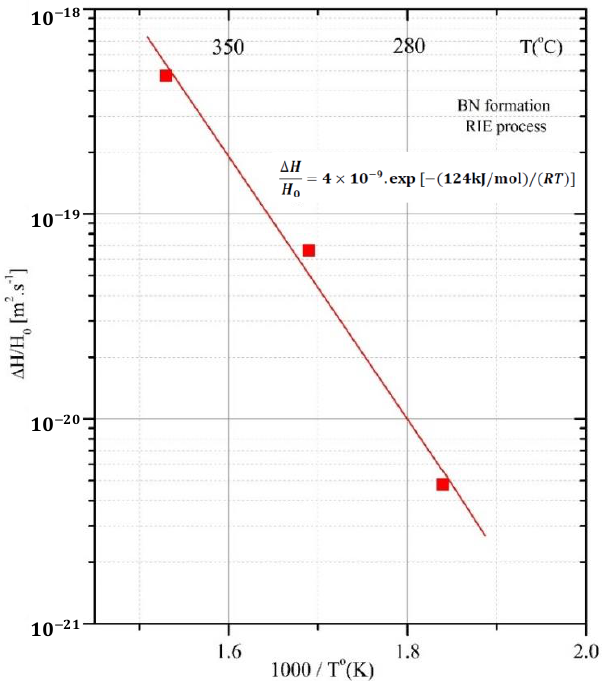
Figure 14. Arrhenius plot of BN phase-formation process via RIE plasma treatment for 10 min in an Ar − N 2 mixture.